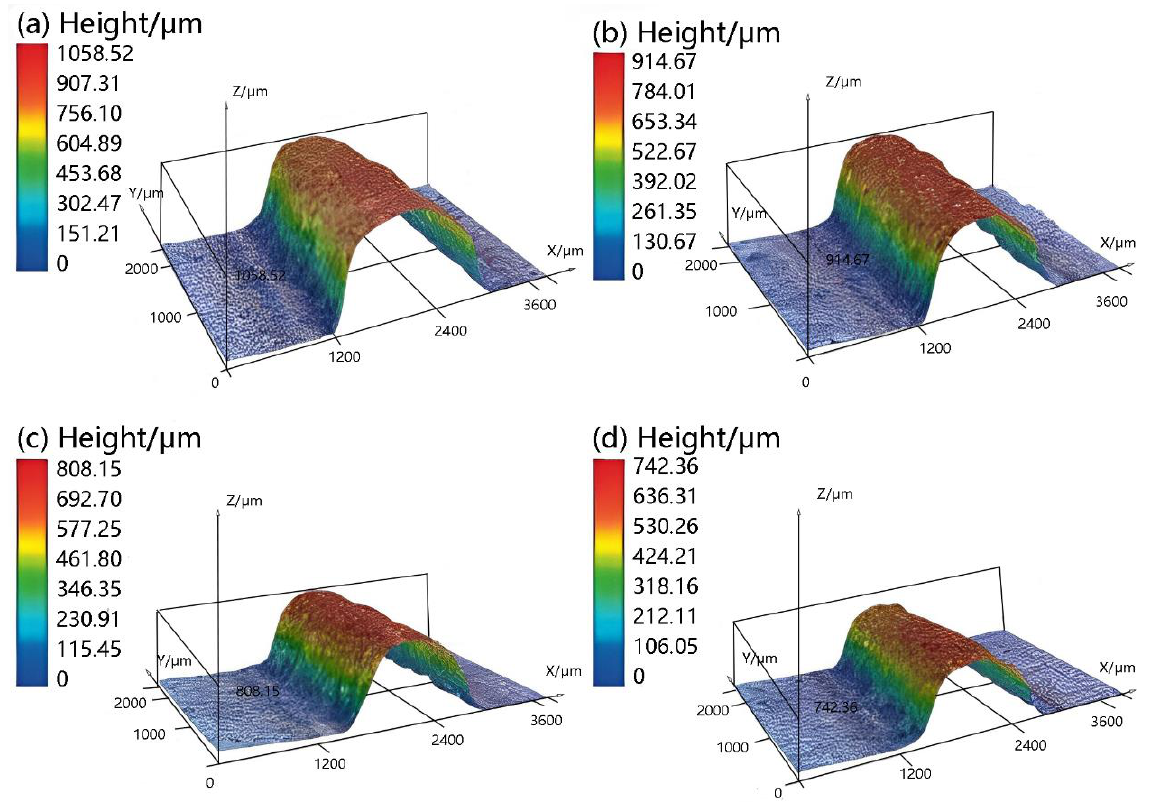
Figure 8. Measurement of the morphology of the deposition layer under different laser power. ( a )